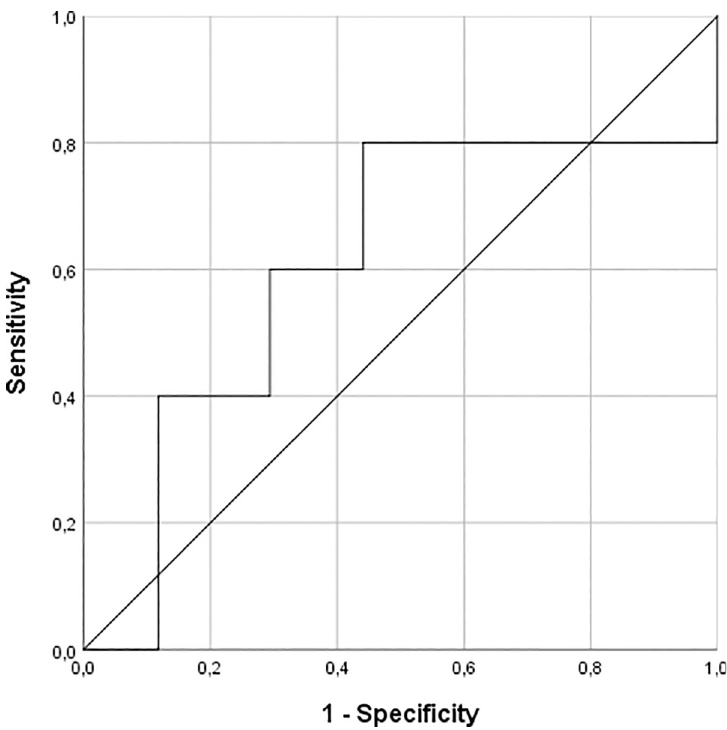
Fig 3. ROC curve of EGF as a predictive marker of platinum-based. Roc analysis shows a low accuracy of EGF as a predictive biomarker of therapy with platinum derivatives within the oncological population (AUC = 0.606).